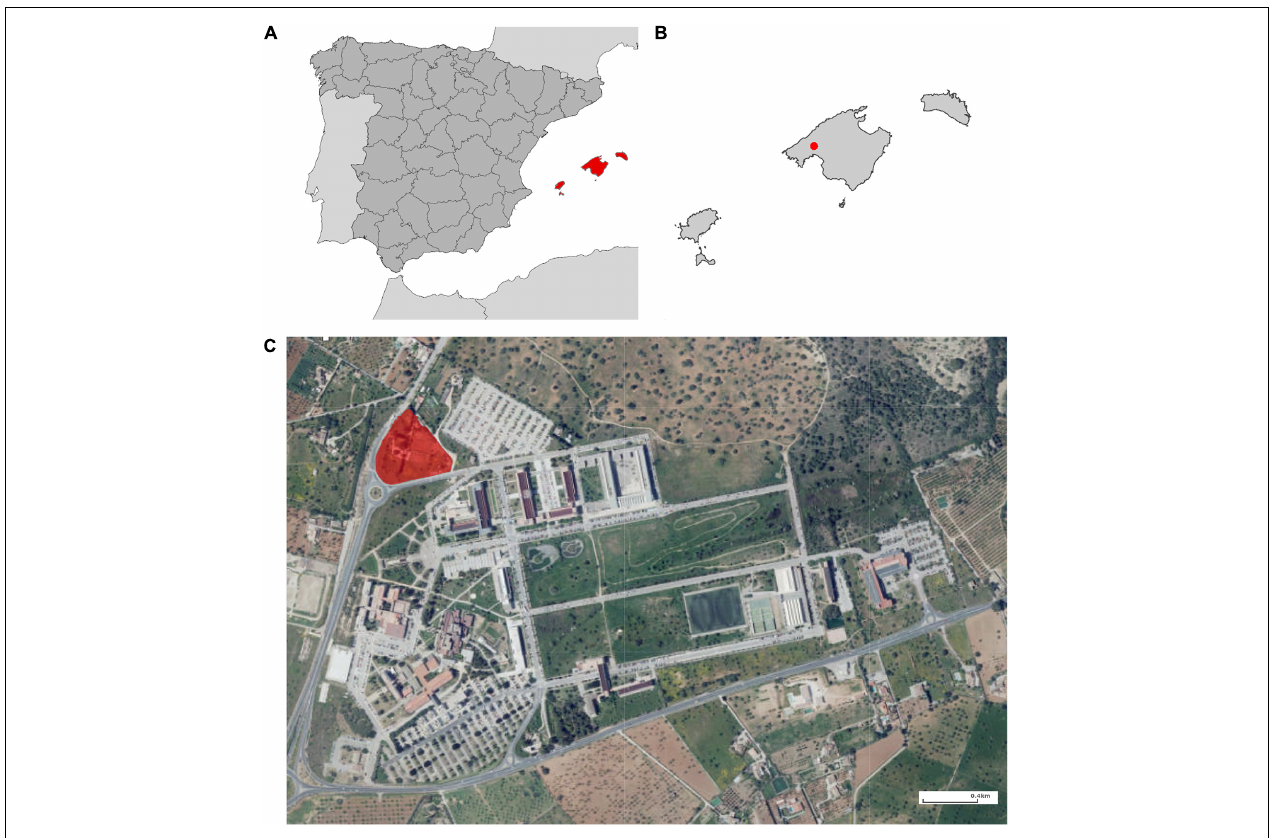
FIGURE 1 | Map of the study area. (A) Spain; (B) Balearic Islands; and (C) Campus of the University of the Balearic Islands. The collection area is highlighted in red.